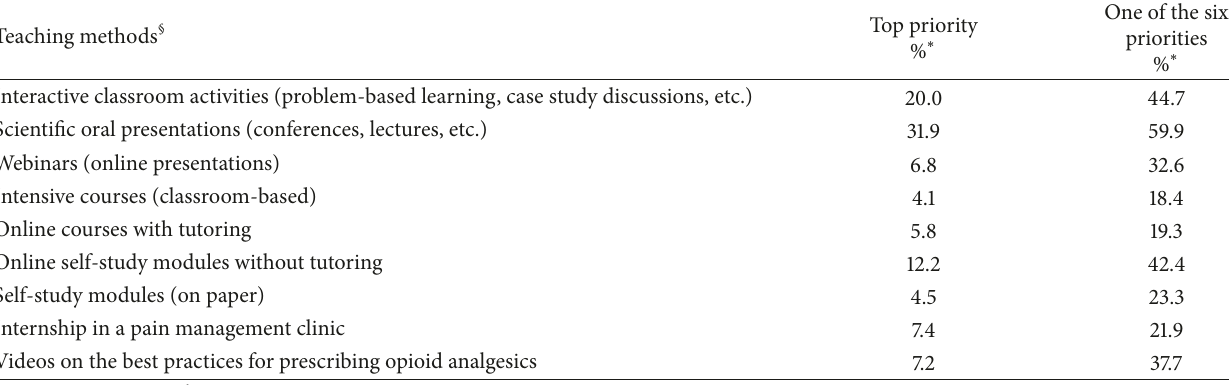
Table 7: Priorities of teaching methods ( 𝑛 = 636